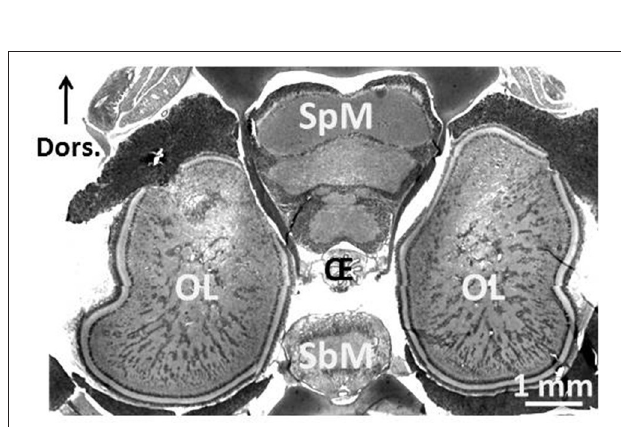
FIGURE 2 | Central nervous system of 3-month-old Sepia officinalis cuttlefish. Frontal section. Prenant-Gabe trichrome stain. Abbreviations: OL, optic lobe; SpM, supra-esophageal mass; SbM, sub-esophageal mass; Oe, esophagus. Modified from Jozet-Alves et al.